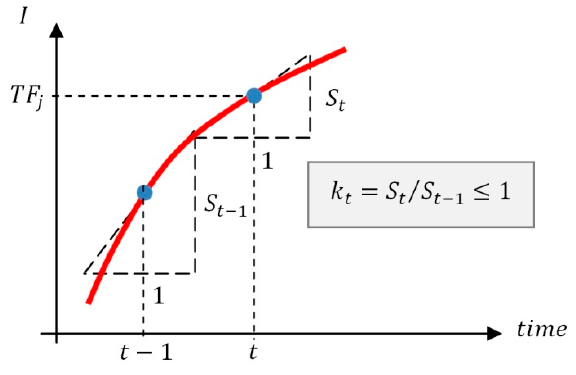
Figure 4. Slope ratio ( 𝑘 (cid:3047) ) of the input hydrograph to the reservoir between two consecutive time Figure4. Slope ratio( k t ) ofthe input hydrograph tothe reservoirbetween twoconsecutive time intervals. intervals.